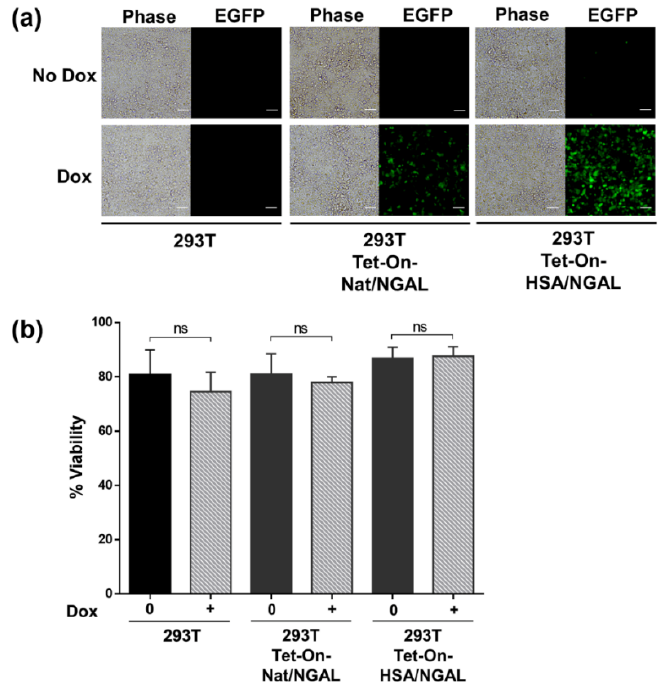
Figure 2. Expression of EGFP and cell viability after Dox induction. ( a ) The EGFP expression was observed under fluorescence microscopy at 20× magnification (Scale bar: 100 µm). ( b ) Cell viability was evaluated by the trypan blue exclusion method. Results were obtained from triplicate experiments (mean ± SD). ns indicated non-significant data at p < 0.05.